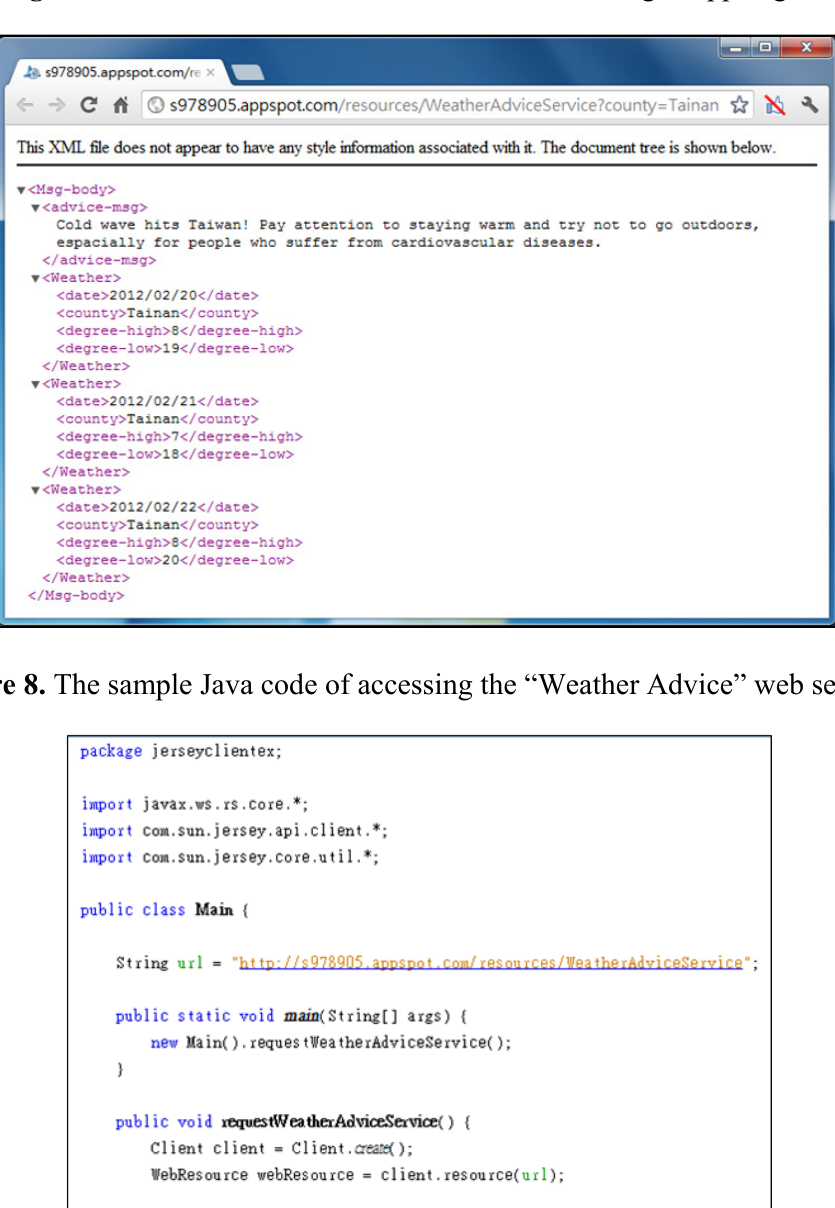
Figure 7. The “Weather Advice” web service in Google App engine.